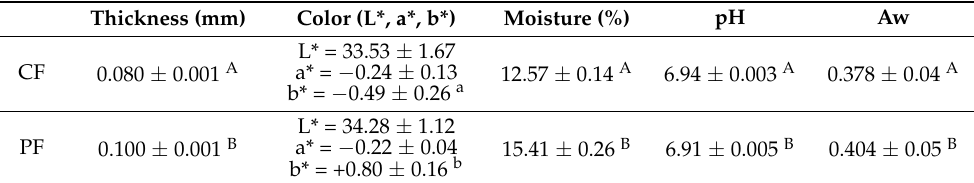
Table 1. Physicochemical characterization of